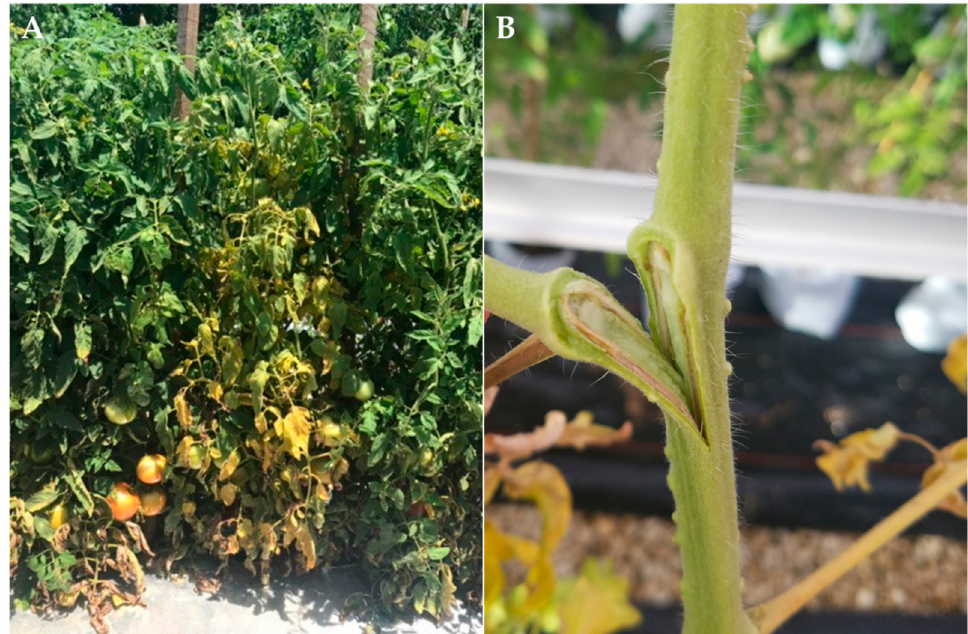
Figure 1. ( A ) Disease symptoms in a susceptible tomato ( S. lycopersicum ) plant grown to near